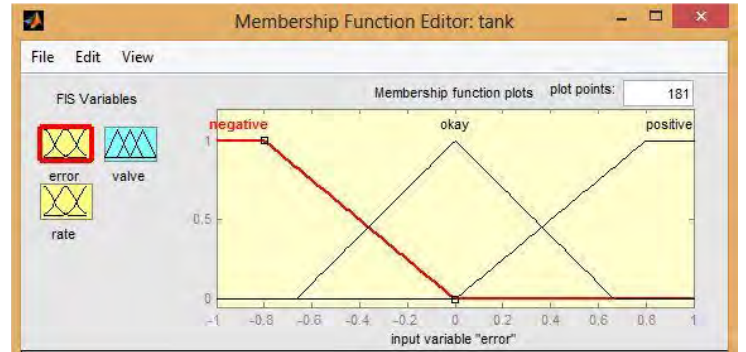
Figure 9. (a) – (c) shows membership